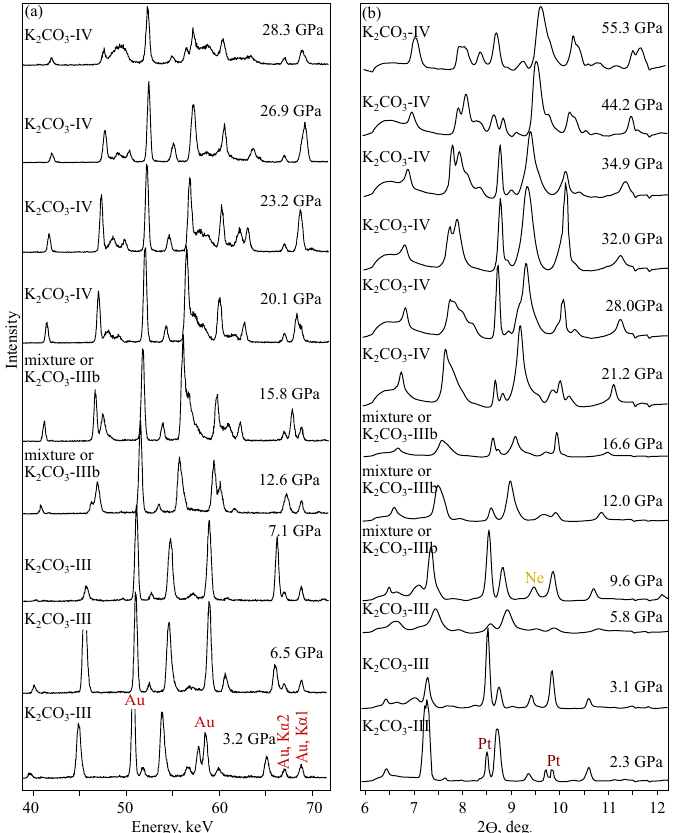
Figure 5. Diffraction patterns of K 2 CO 3 collected in MA ( a ) and DAC-APS ( b ) experiments at room